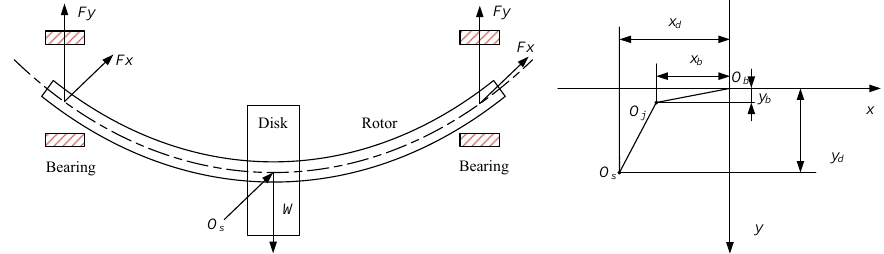
Figure 3. Diagram of a rotor-bearing system and coordinates in the x - y